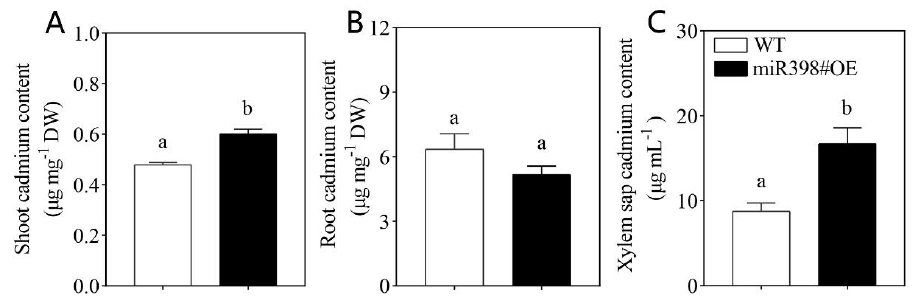
Figure 4. Cadmium contents in the shoot ( A ), root ( B ), and xylem sap ( C ) in wild type (WT) and transgenic line overexpressing MIR398 (miR398#OE) under cadmium stress. Tomato seedlings (25 d old) of WT and miR398#OE were grown 100 μM Cd(NO 3 ) 2 for 9 d. The data are the mean values + SD of four individual replicates and different letters indicate significant differences ( p < 0.05). DW, dry weight.